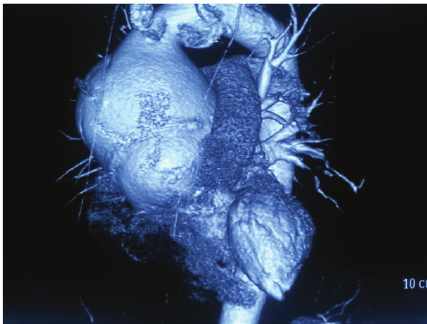
Figure 1: Computerized tomography shows ascending aortic aneurysm.